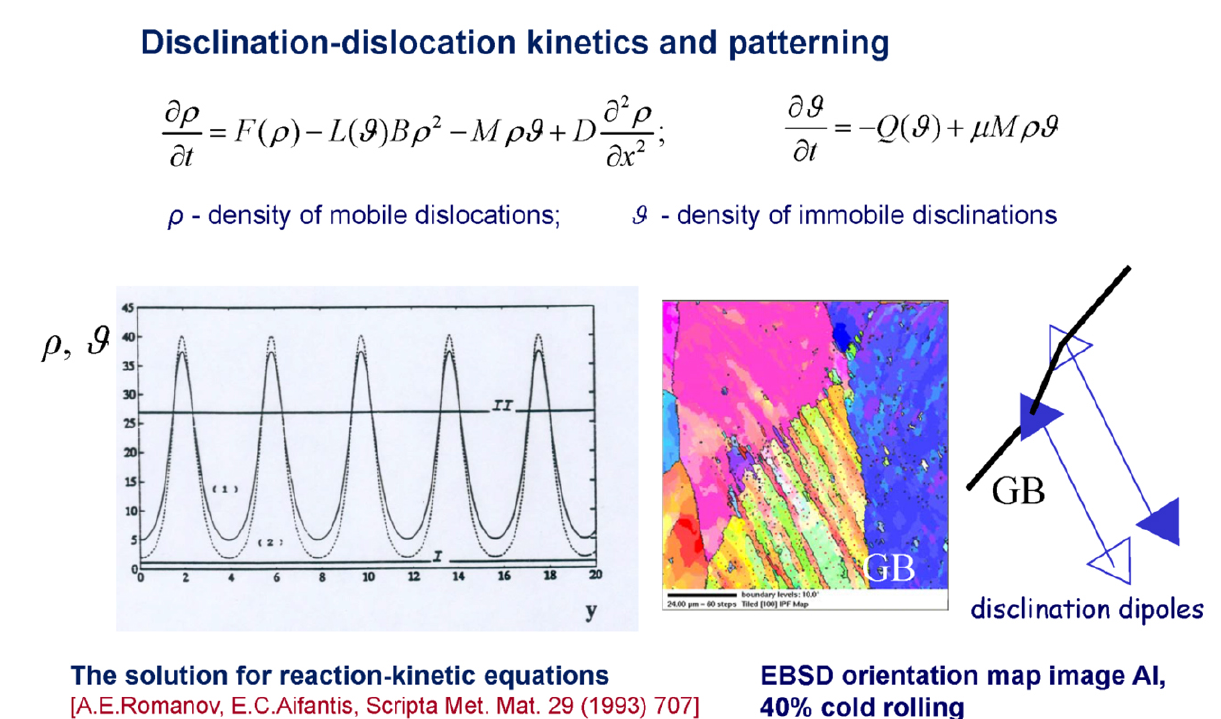
Figure 2: The R-A model for dislocation ( ρ ) – disclination ( θ ) populations, its spatially periodic solution and its applicability to interpret periodic orientation bands observed in electron micrographs. For related details the reader can consult [3, 11c] and references quoted